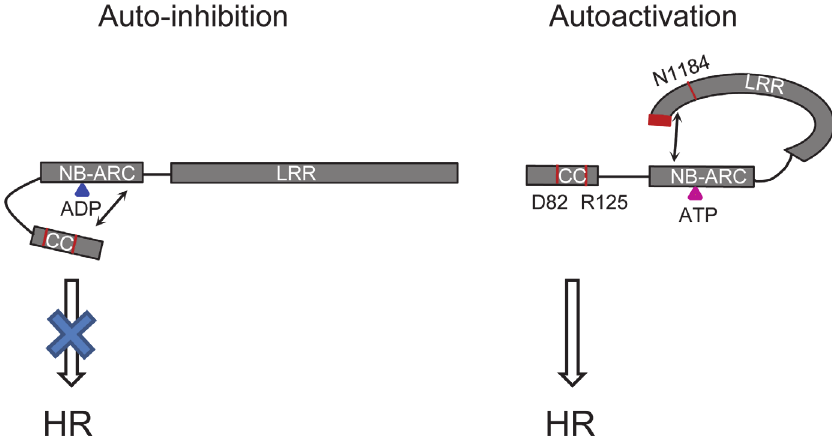
Fig 11. Model of the intra-molecular interactions controlling auto-inhibition or auto-activation in Rp1 proteins. In the auto-inhibited state (left), the NB-ARC domain inhibits CC-induced HR via intra-molecular interaction involving the ARC2 domain. In the auto-activated state (right), the LRR suppresses an inhibitory effect of the NB-ARC on the CC through direct interaction with the NB-ARC which destabilizes the CC/NB- ARC interaction. Blue and pink triangles indicate ADP and ATP, respectively. Arrows indicate intra-molecular interactions. The positions of amino acids (D82, R125, N1184 and the C-terminal 16 amino acids) which are important for activity are labeled in red. The rationale behind the models is explained in the main